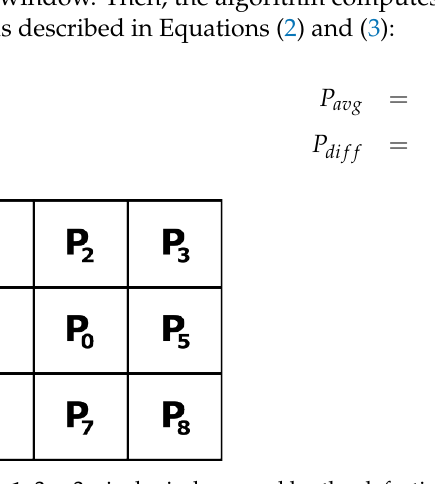
Figure 1. 3 × 3-pixel window used by the defective pixel detection algorithm; P 0 is the pixel under test and P 1 – P 8 are its